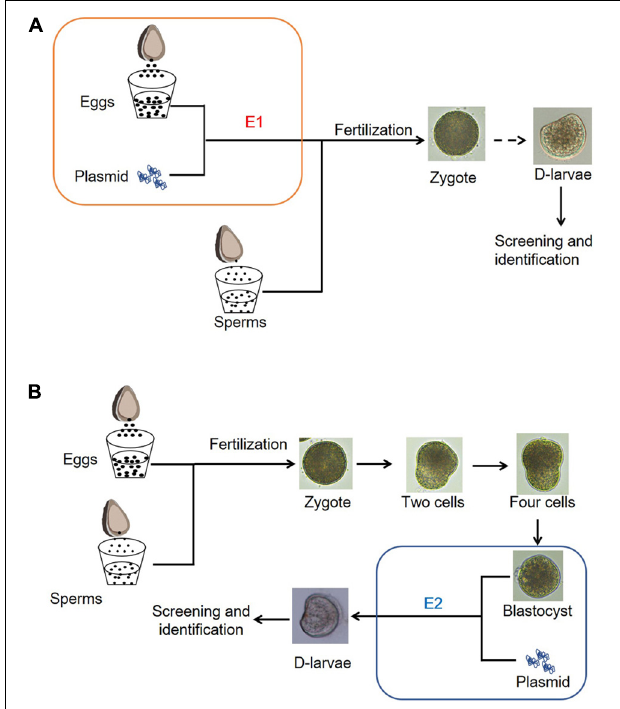
FIGURE 1 | Schematic diagram of the mode of electroporation. (A) Eggs of the Fujian oyster were collected and then performed by electroporation before fertilization with sperms. (B) Electroporation was performed with blastula